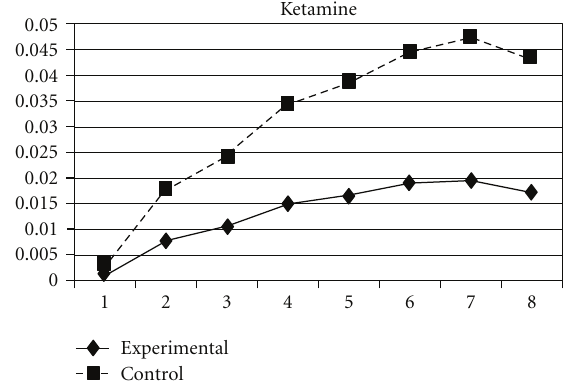
Figure 11: Growth trajectories of the experimental group (all par- ticipants) and control group using the item score of solvent use as the outcome